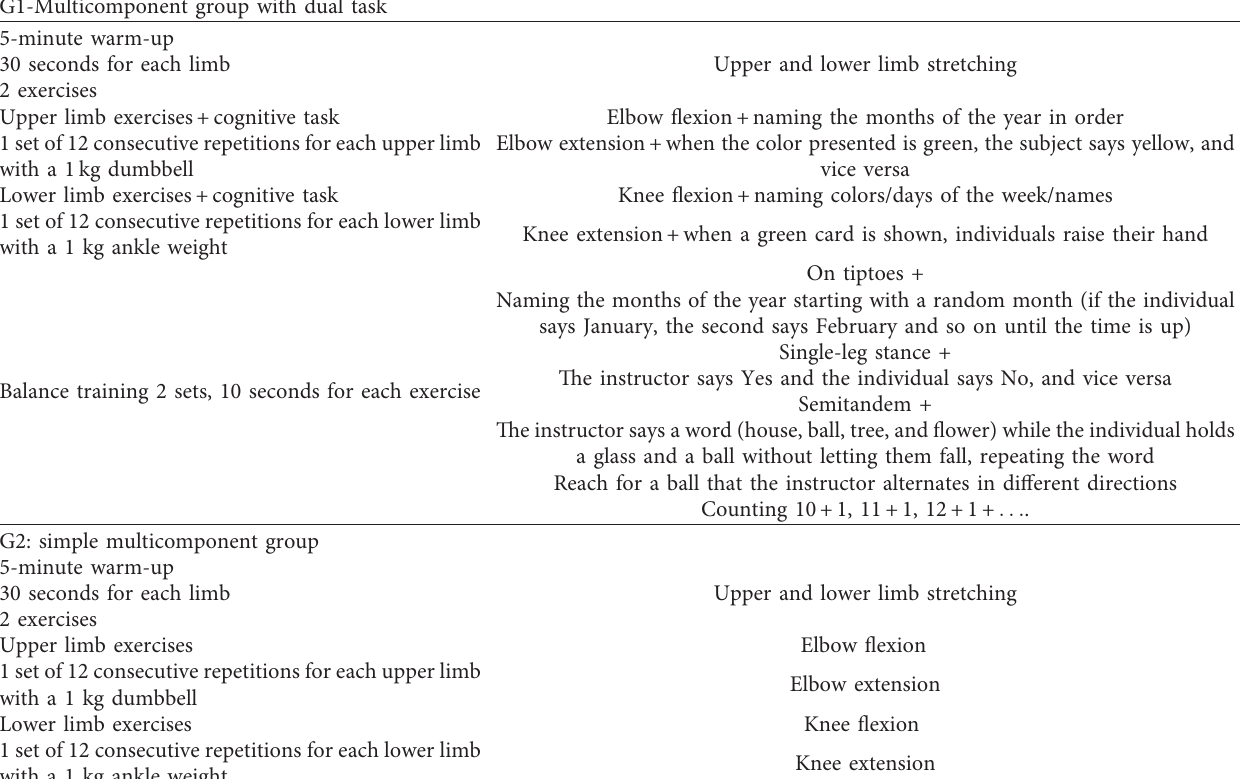
Table 2: Description of the adapted program applied to each group